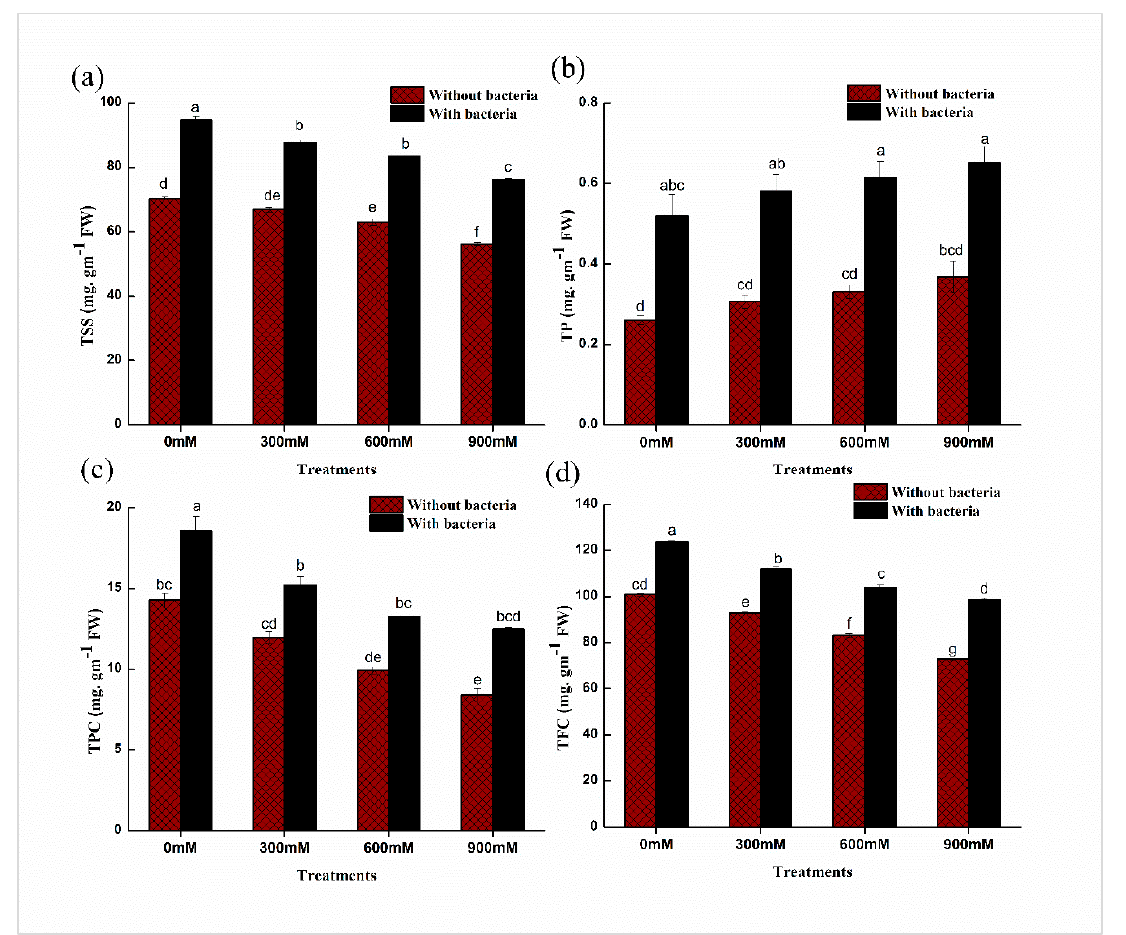
Figure 5. Effects of E. cloacae PM23 on ( a ) Total soluble sugars ( b ) Protein content ( c ) Phenolic content ( d ) Flavonoid content. The a, b, c, d, e, f, g inside the figure (on top of the bar graphs) refer to the same meaning in the caption.